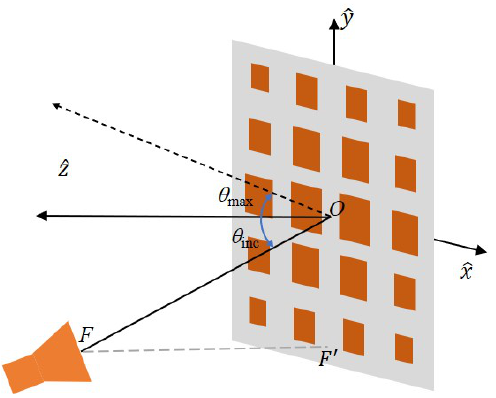
Figure 4. Sketch of the considered reflectarray (RA)